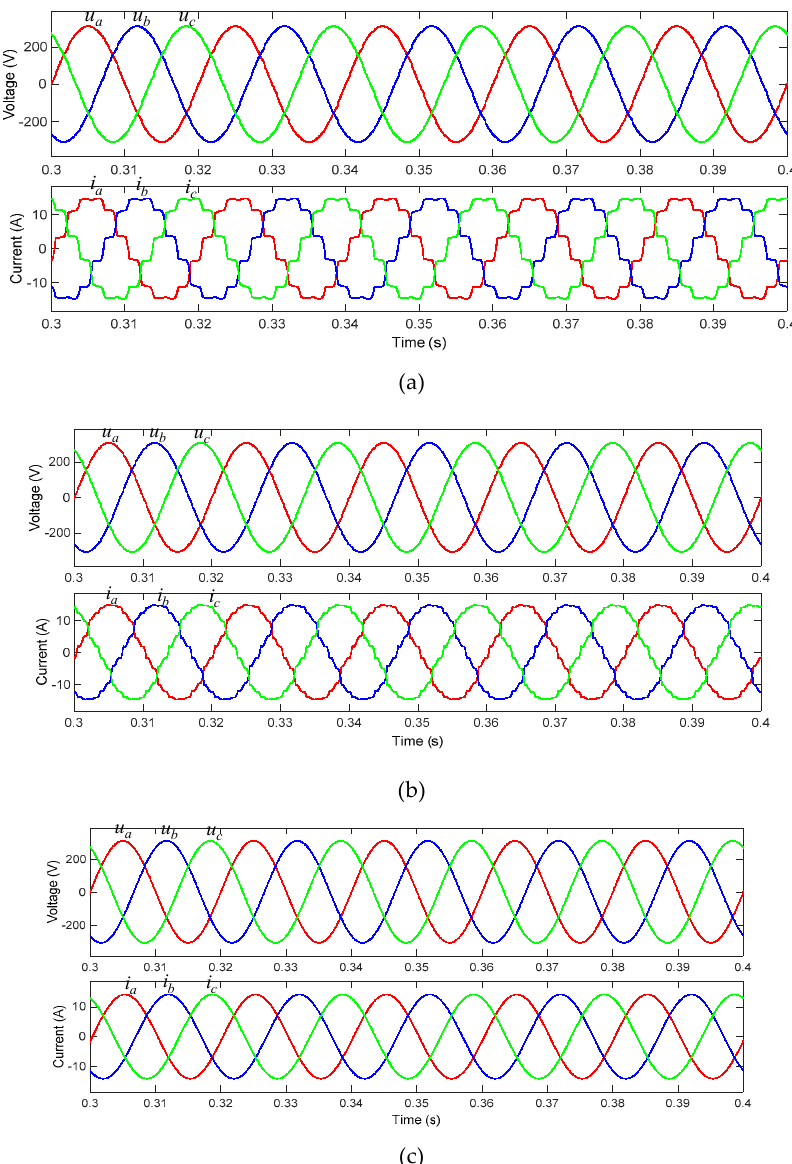
Figure 8. Grid voltages and currents simulation waveforms. ( a ) Without filter, ( b ) the PF method, ( c ) the IF method.